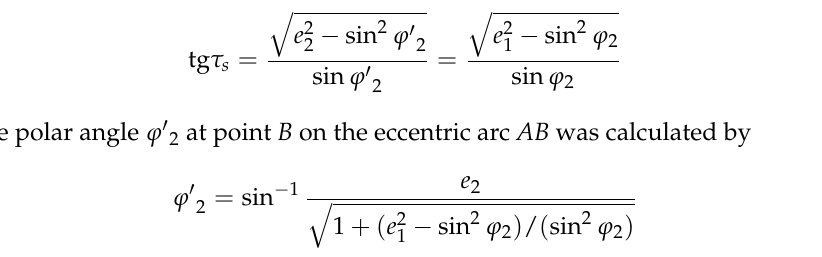
The radius R 2 of the eccentric circle and the polar angle ϕ 0 at point A were calculated by Equations (6) and (7). In the field operation of the rotary tiller, there is an angle ∆ τ between the absolute velocity v a and the relative velocity v r at each point on the edge curve. ∆ τ is the difference between the dynamic sliding–cutting angle and the static sliding–cutting angle of the up-cut rotary blade, as shown in Figure 5. According to the trigonometric function relationship, ∆ τ was calculated